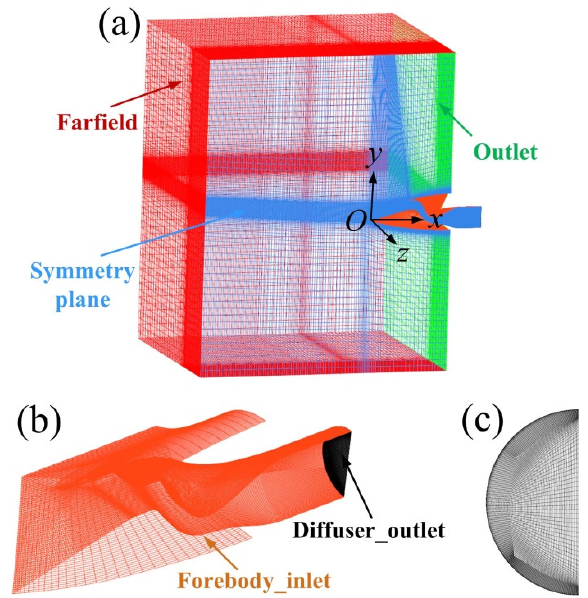
Figure 4. Computational grid used in the current study: ( a ) Global view of the whole computational domain; ( b ) Close view of the surface mesh on the forebody-inlet integration; ( c ) Close view of the O-type mesh at the AIP. Table 2. Boundary condition settings for the computational domain.